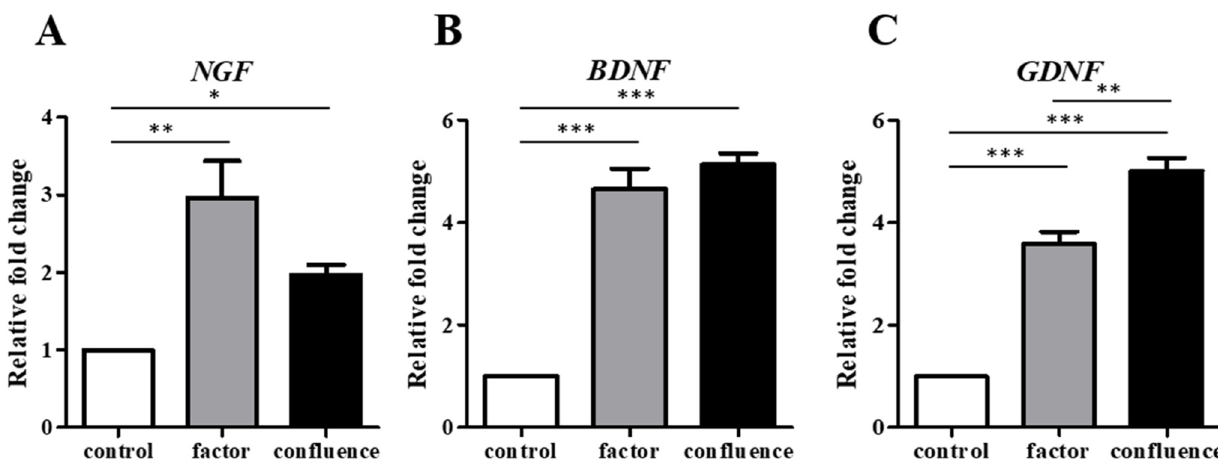
Figure 4. Neurotrophic gene expressions of the ADSCs during factor-induced and confluence-initiated neurogenic differentiation. Neurotrophic gene expressions, including the nerve growth factor ( NGF ) ( A ), brain-derived neurotrophic factor ( BDNF ) ( B ), and cell-derived neurotrophic factor ( GDNF ) ( C ) in the factor-induced (factor) and confluence-initiated (confluence) differentiated ADSCs on day 7 were detected by RT-qPCR. The value of each gene expression was normalized to the expression of glyceraldehyde-3-phosphate dehydrogenase ( GAPDH ). Relative fold changes of the values of the factor-induced and confluence-initiated differentiated ADSCs were compared with the value of the control (without induction) as one. The values are expressed as mean ± SEM with three experimental replicates. Statistical significance was determined using the one-way ANOVA test. “*” represents p < 0.05. “**” represents p < 0.01. “***” represents p < 0.001.